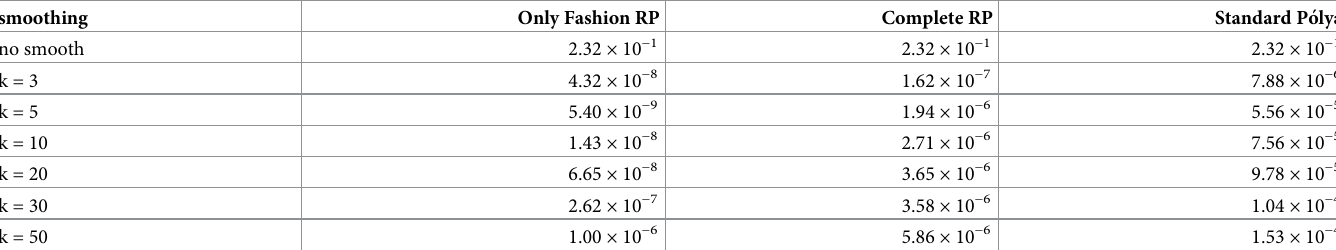
Table 21. “10 days of traffic” ( T = 0.5, entire, D = 30 00 , slots = days): MSE for different levels of smoothing.